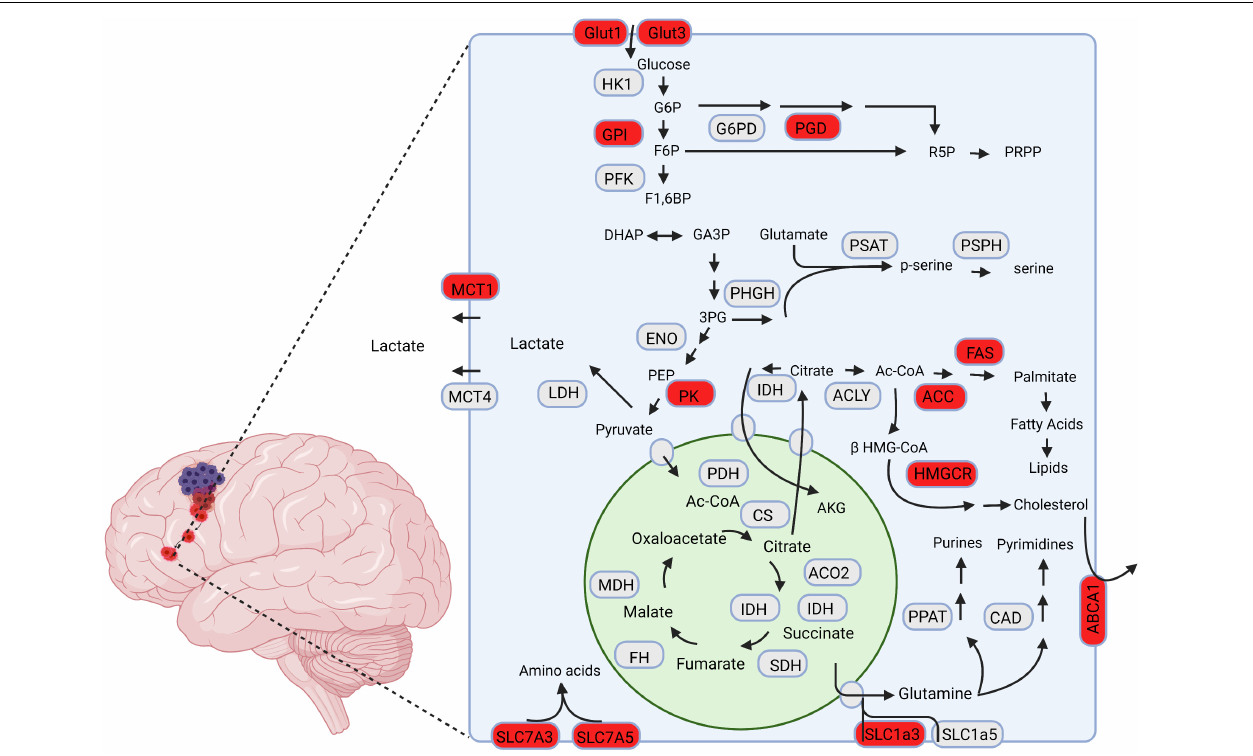
FIGURE 1 | A schematic representation of metabolic pathways associated with GBM invasion. The proteins highlighted in red are hypothesized to drive invasion in GBM cells. Created using Biorender.com.